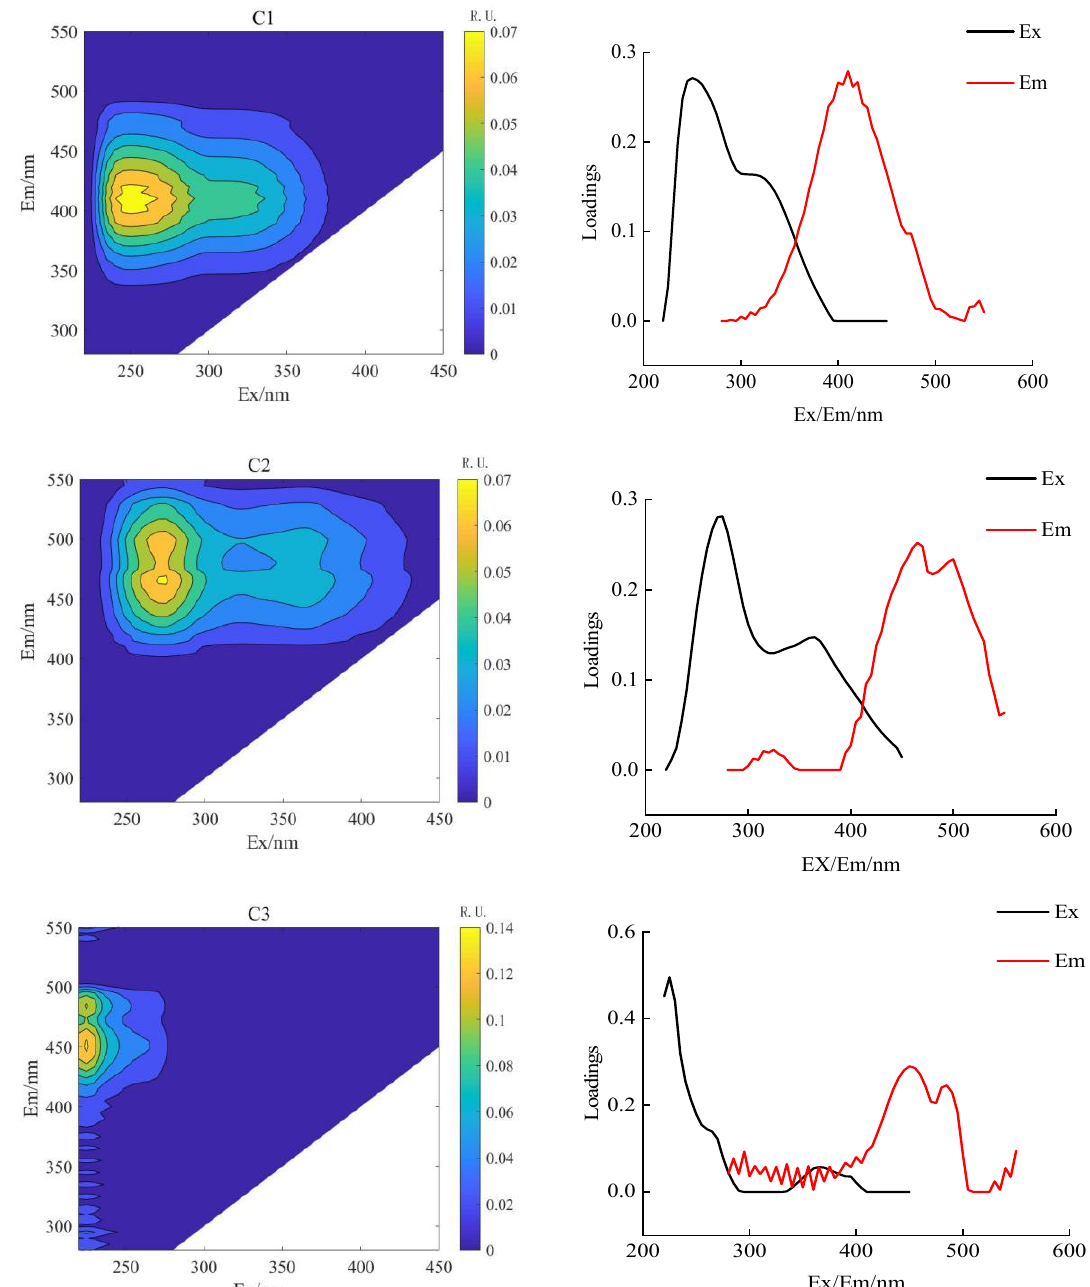
Figure 5. Analysis of soil DOM parallel factor in aerated drip irrigation.